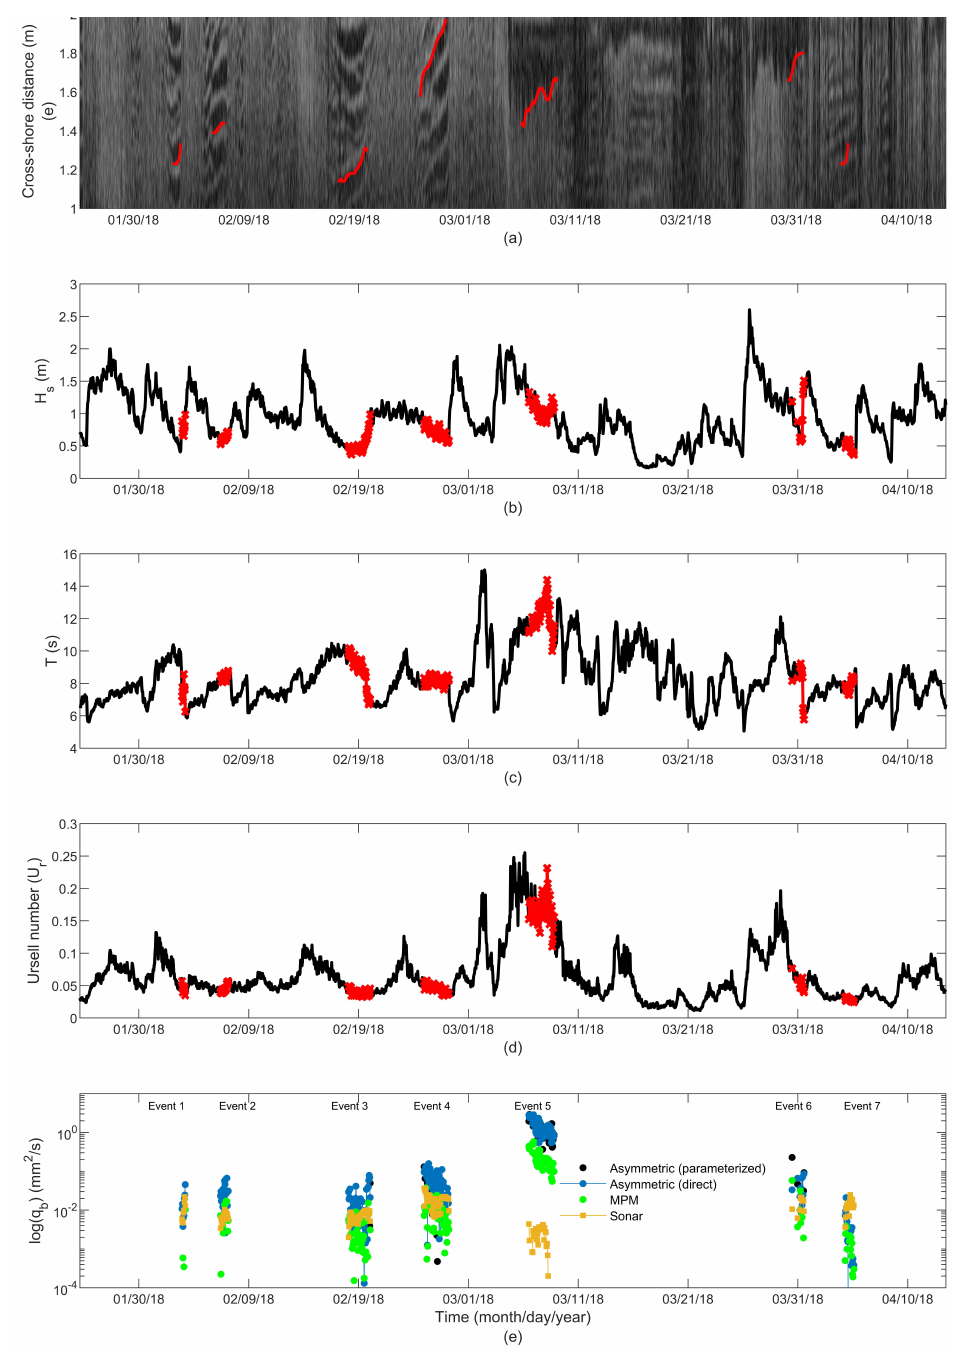
Figure 11. ( a ) Time stacked sonar imagery at the Matanzas Inlet site with periods of ripple tracking shown in red, ( b ) significant wave height, ( c ) representative wave period with red markings corre- sponding to the periods of ripple movement, ( d ) Ursell number with red markings corresponding to the periods of ripple movement, and ( e ) instantaneous bedload on a log scale in mm 2 /s comparing the bedload with parameterized (black) and direct (blue) waveforms using the asymmetric bedload formulation (Appendix B), MPM (green) method (Appendix C) and sonar imagery (brown). Event numbers are marked corresponding to the seven ripple migration events tracked in the sonar data (Figure